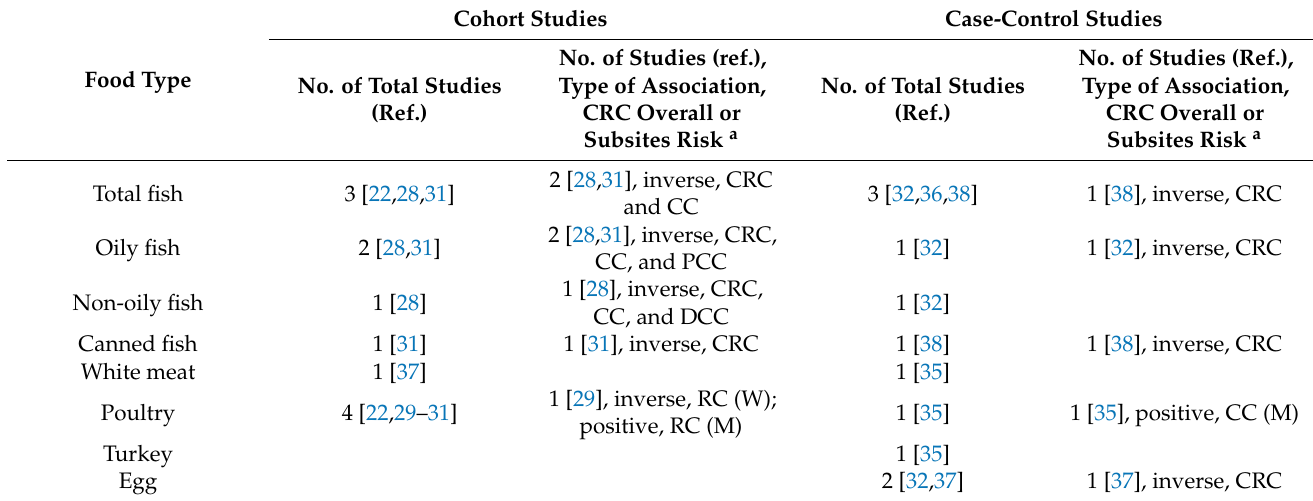
Table 6. Summary of the findings found in the reviewed articles examining the association between the consumption of fish, white meat, and eggs and the risk of colorectal